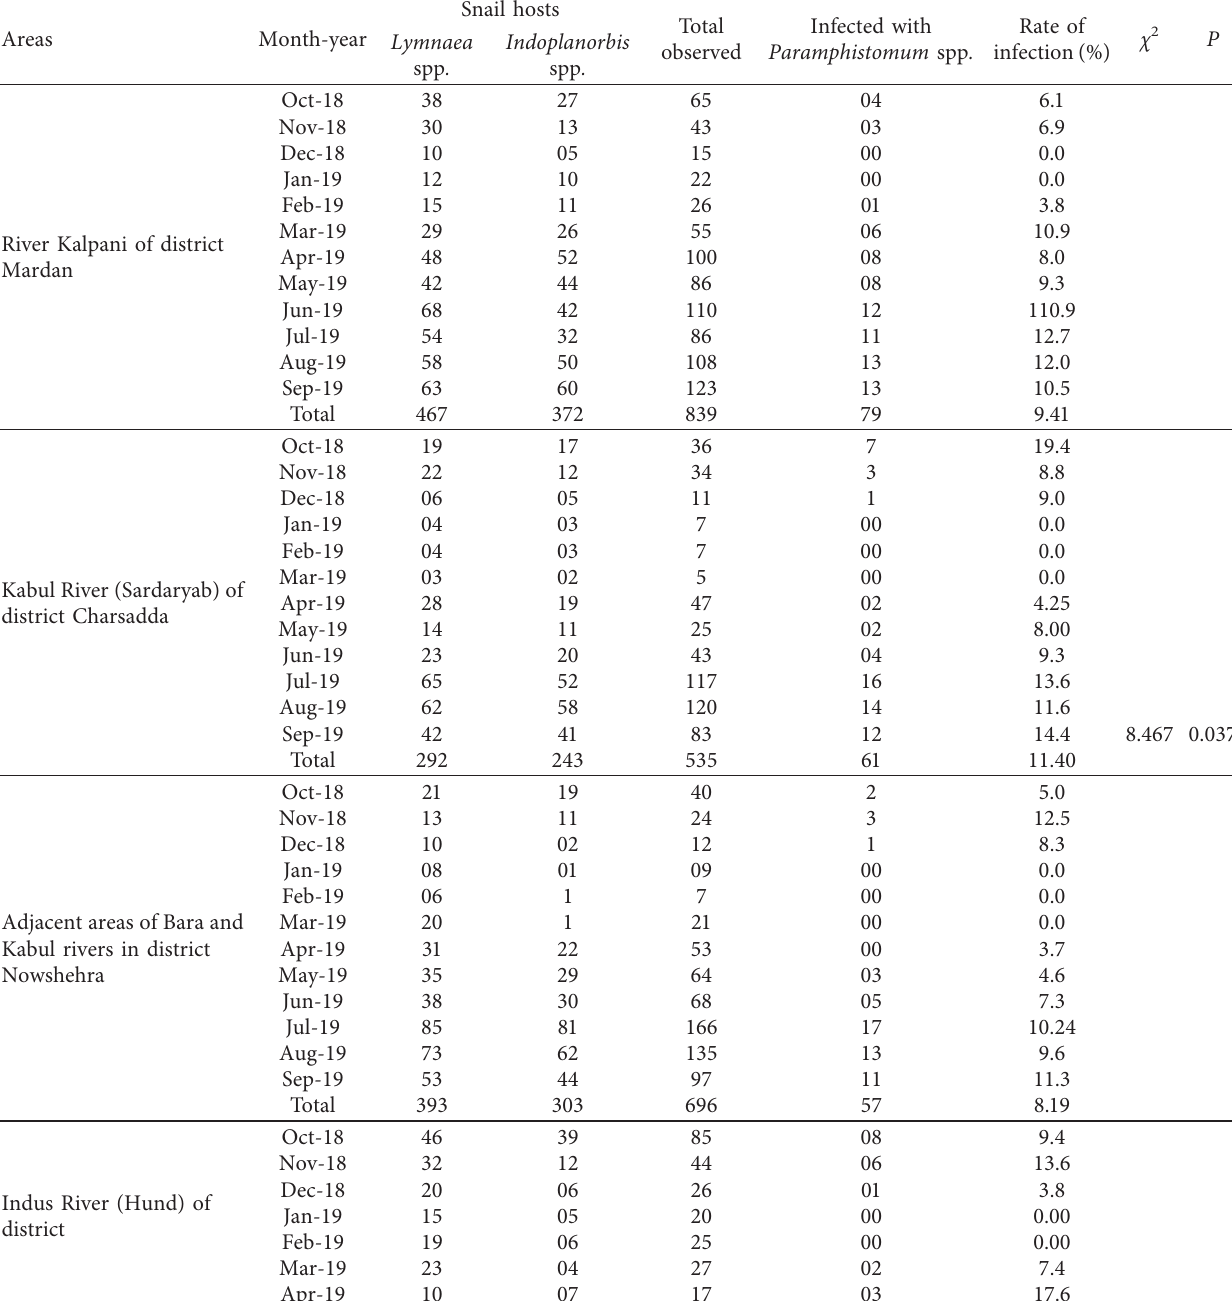
Table 2: Areawise and monthwise prevalence of Paramphistomum spp . cercariae infection in Indoplanorbis and Lymnaea intermediate snail hosts in various districts of Khyber Pakhtunkhwa, Pakistan. Areas Month-year